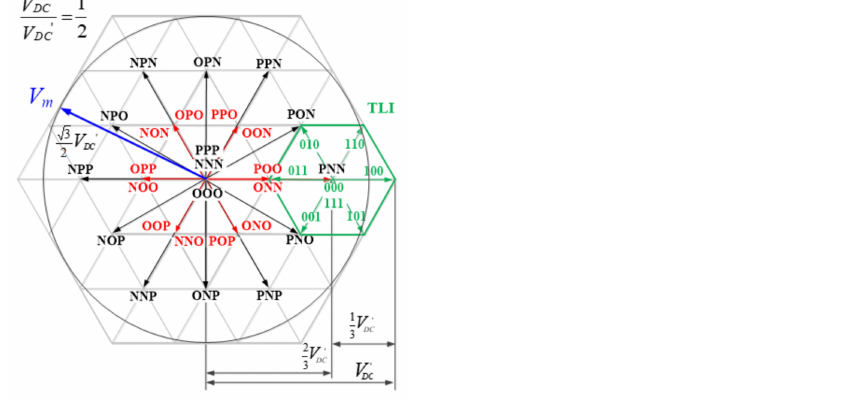
Figure 4. Three-level neutral point clamped (NPC) + TLI voltage space vector diagram ( V DC (cid:48)(cid:48) / V DC (cid:48) = 1/2). Table 2. Six-level MMC low voltage